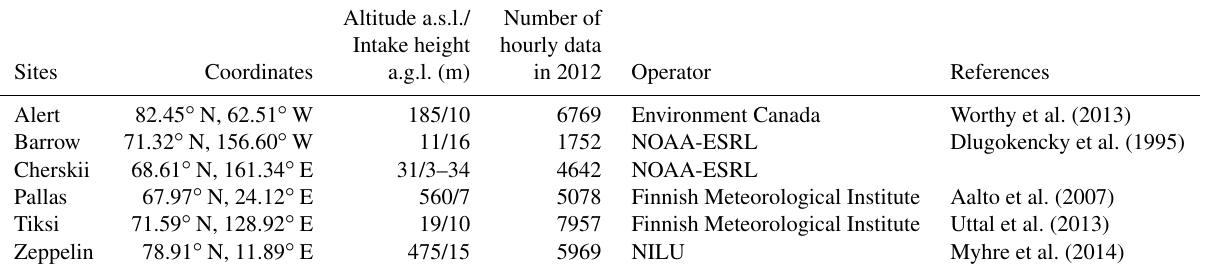
Table 1. Description of the six continuous measurement sites used in this study.